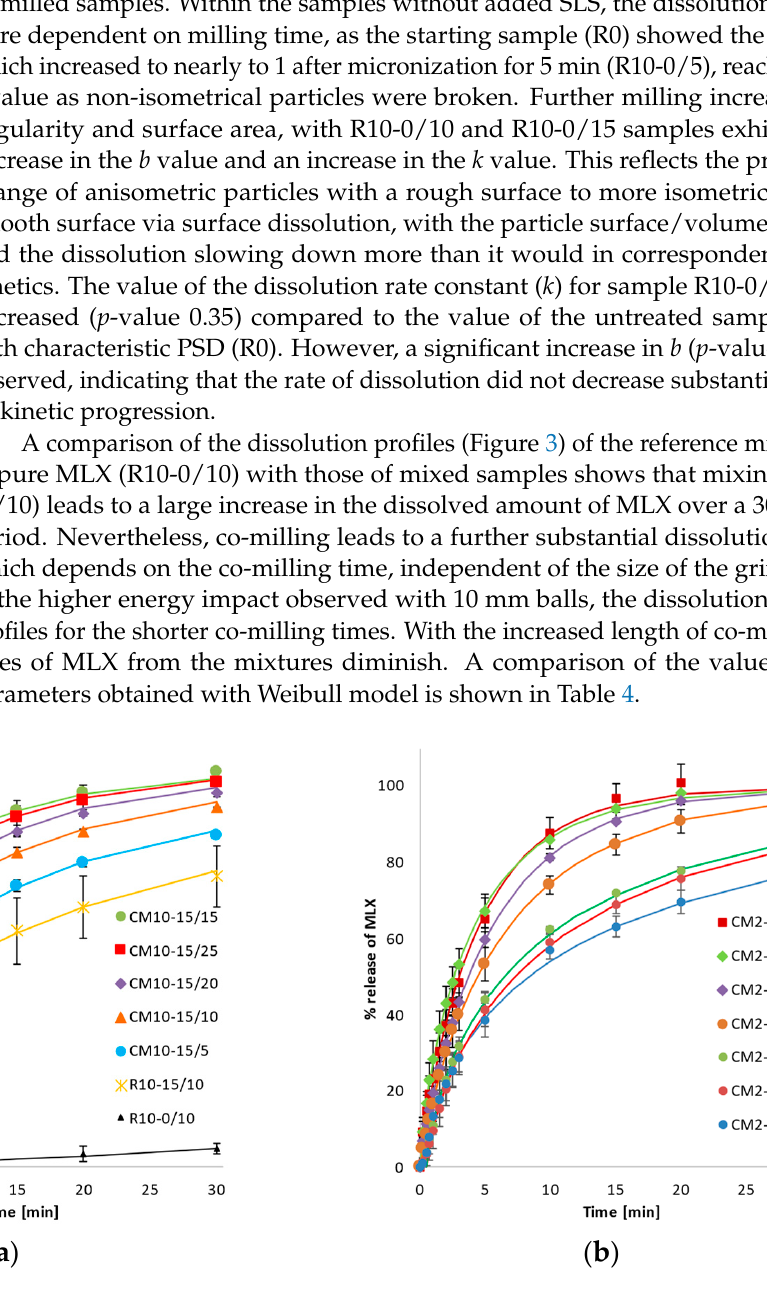
Figure 3. Dependence of MLX released on time for reference and co-milled samples with 15 wt.% SLS content. Experimental points fitted with the Weibull model. Comparison of ( a ) micronized reference samples without (R10-0/10) or mixed with SLS (R10-15/10) and co-milled mixtures with 10 mm balls in the time range of 5 to 25 min; ( b ) co-milled mixtures with 2 mm balls in the time range of 5 to 35 min.